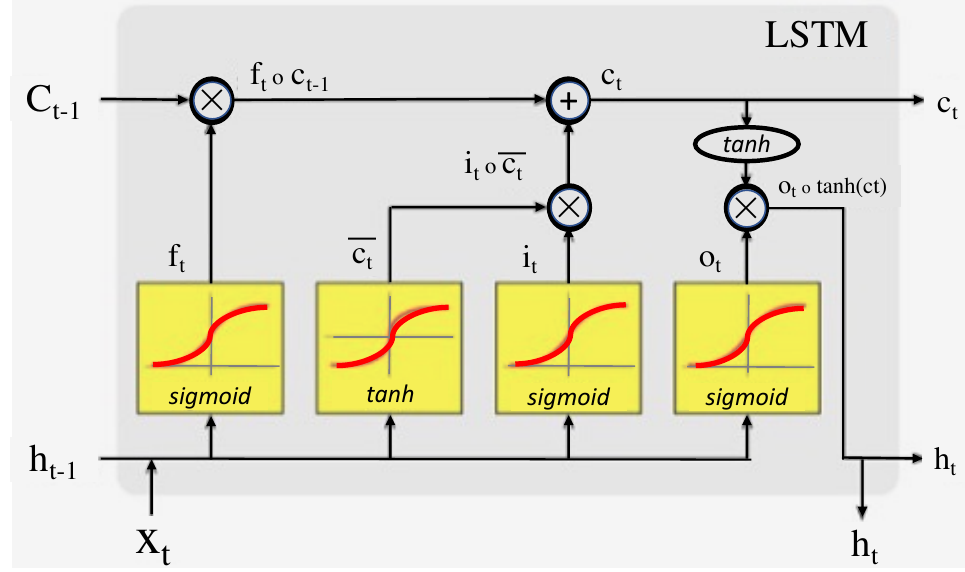
Figure 9. LSTM Cell.